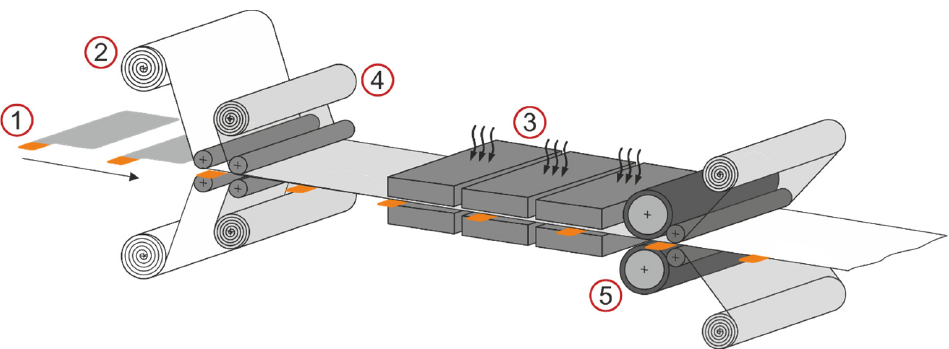
Figure 1. Schematic representation of the lamination process with discrete electrode feed (1), web- bound separator feed (2) and a separate preheating zone (3) in front of the lamination rollers (5). A protective film (4) covers the electrodes and separator during lamination.